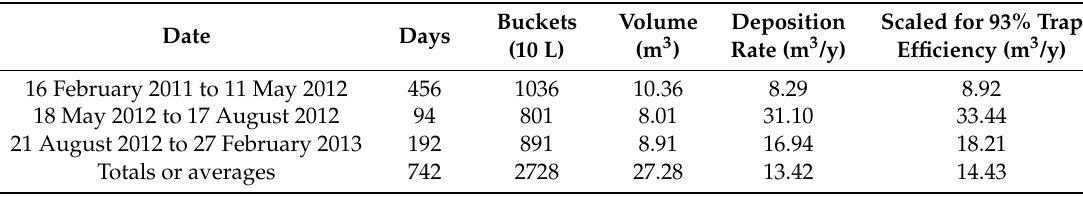
Table 1. Sediment accumulation behind silt fence dam, volume measured by sediment removal using 10 L